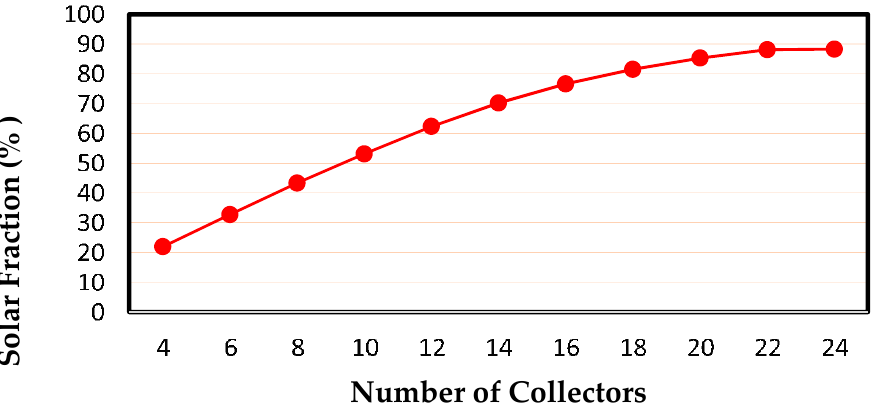
Figure 11. Solar coverage as a function of the number of